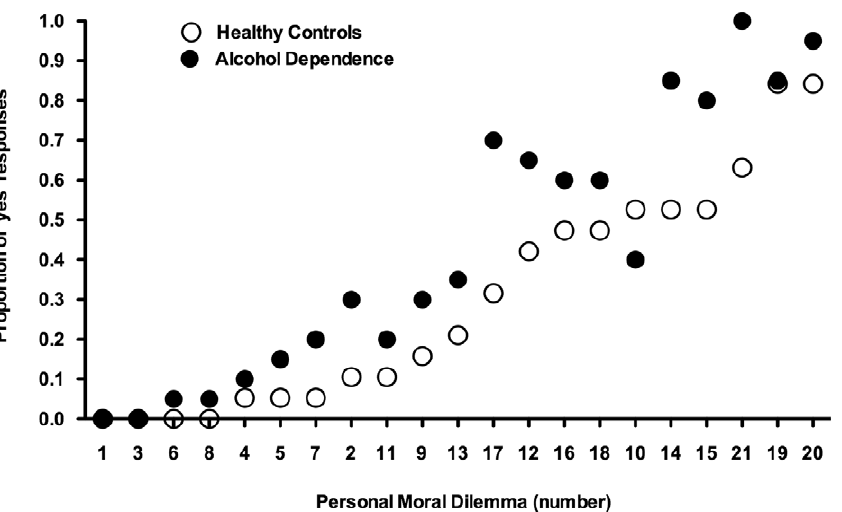
Figure 3. Moral judgment on each moral personal dilemma. The proportion of ‘yes’ responses are shown for the two groups for each of the 21 moral personal dilemmas. The dilemma numbers are directly adapted from Koenigs et al. (2007) and sorted according to increasing proportion of ‘yes’ responses, i.e. endorsing the proposed utilitarian action, by the healthy controls. Dilemmas labelled 1–8 and 9–21 are low-conflict type and high- conflict type respectively. Alcohol dependent patients responded equally or more utilitarian than healthy controls for all personal moral dilemmas except one, and the difference in response was more pronounced for the high-conflict dilemmas (P=0.036) compared to low-conflict dilemmas (P=0.063).